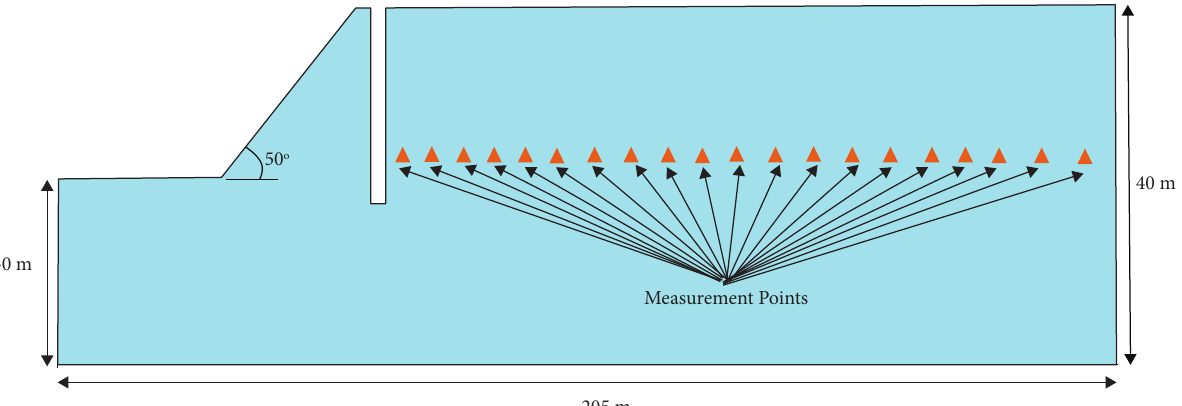
Figure 6: Basic geometry of the numerical model of the blasting process in one of the benches of the Sangan iron ore mine.